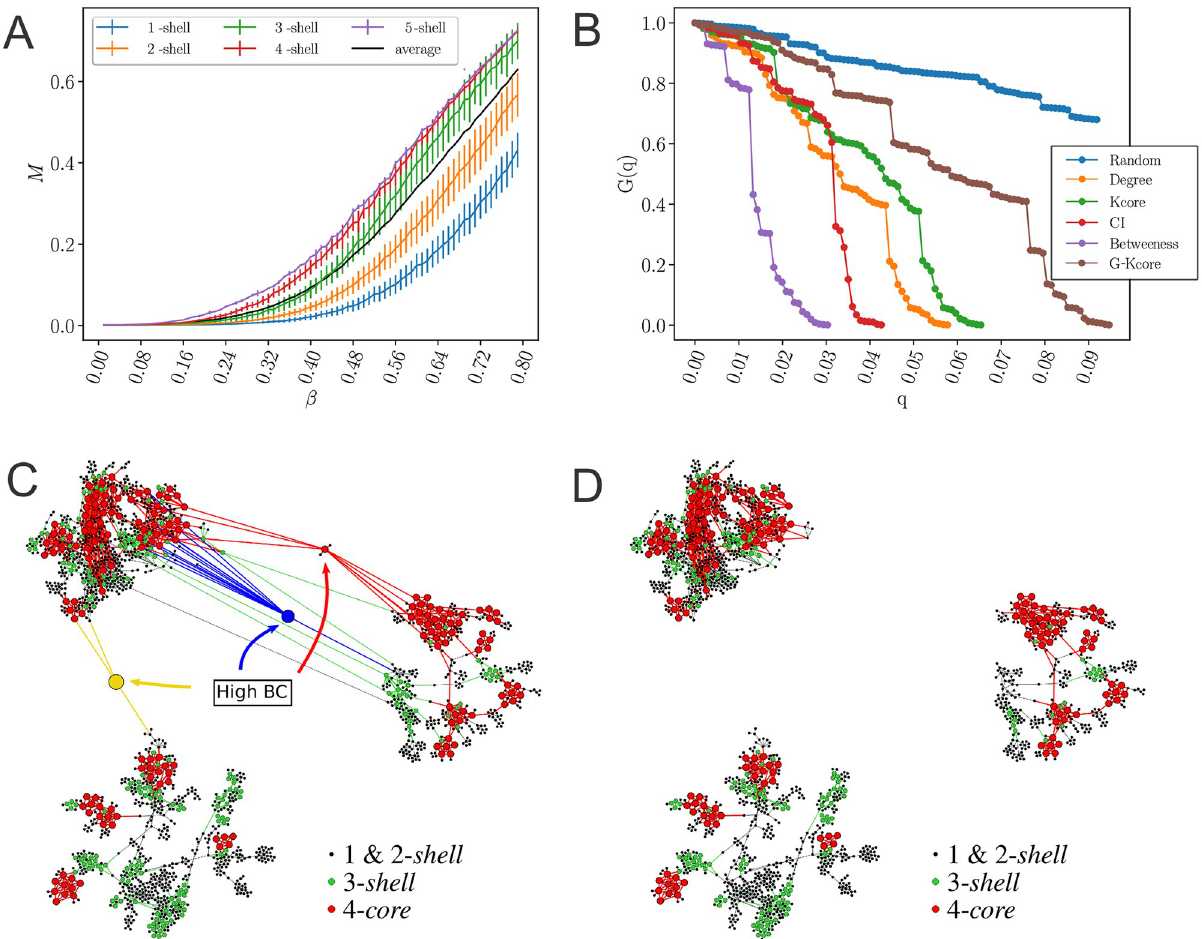
Fig 5. Weak links and k-cores. (A) Average size of infected population, M [33], in an outbreak average over all starting nodes in a k-shell as a function of the probability of infection β for a SIR model on the network in Fig 4C during the lockdown. The black is the average value over all the network. The average divides the k-shell contribution to the spreading of the virus in two groups: above and below the average. The 0.5-cores have maximal spreading and the 0.5-shell have minimal spreading. Error bars correspond to a confidence interval of 95%. (B) Optimal percolation analysis performed over the network in Fig 4C during the lockdown in following different attack strategies and their effect on the size of the largest connected component G ( q ) versus the removal node fraction, q . Nodes are removed (in order of increasing efficiency): randomly (blue); by the highest k-shell followed by high degree inside the k-shell [33]; by highest degree (orange); by collective influence (red) [20]; by the highest generalized k-core (brown) [37]; and by the highest value of betweenness centrality (green) [38, 39]. After each removal we re-compute all metrics. The most optimal strategy among those studied is removing the nodes by the highest value of betweenness centrality. (C)-(D) Effect of removing three high betweenness centrality nodes shown in Fig 5B in the network of Fig 4C. (C) We show the 2-core component of the network after the removal of 12 high betweenness centrality nodes. The red node is the one with the highest betweenness centrality value (next node to remove, 13th) and the blue node is the 14th removal. Different k-cores and k-shell are in different colors. (D) Network k-cores are disintegrated after the removal of the high BC nodes.